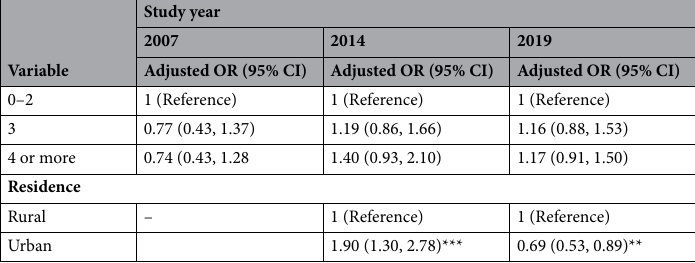
Table 5. Adjusted associations with meeting 5–7 ideal cardiovascular health metrics. OR = odds ratio; CI = confidence intervals. * p < 0.05; ** p < 0.01; *** p <